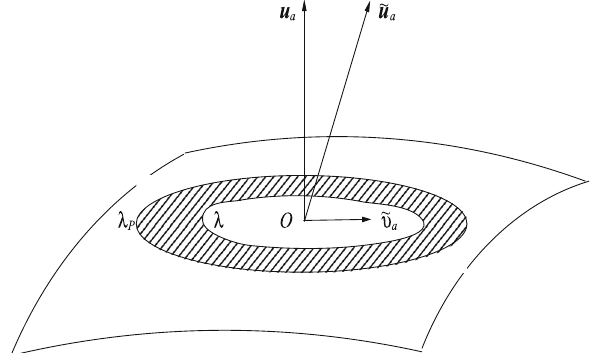
Fig. 3 Observer ( O ) inside a bulk flow (central section) like those quoted in Table 1, with 4-velocity ˜ u a and peculiar velocity ˜ v a , relative to the smooth Hubble expansion (identified with the u a -field). Around the observer there is a spherical region (shaded area), with size deter- mined by the associated peculiar Jeans length ( λ P ) and corresponding to redshift z λ . In the case of contracting bulk flows, the outer limits P of the shaded domain mark the transition scale, where the locally mea- sured deceleration parameter ( ˜ q ( − ) ) turns from positive to negative (see Table 1). Put another way, the value of ˜ q ( − ) becomes progressively less negative away from the observer at O , it crosses the zero threshold at the transition scale and starts taking positive values beyond λ P , even- tually approaching q = 1 / 2 on large enough lengths (see Fig. 2). The unsuspecting observer may then be mislead to believe that the universe started to accelerate at z = z λ and in so doing misinterpret the local P change in the sign of ˜ q ( − ) as recent global